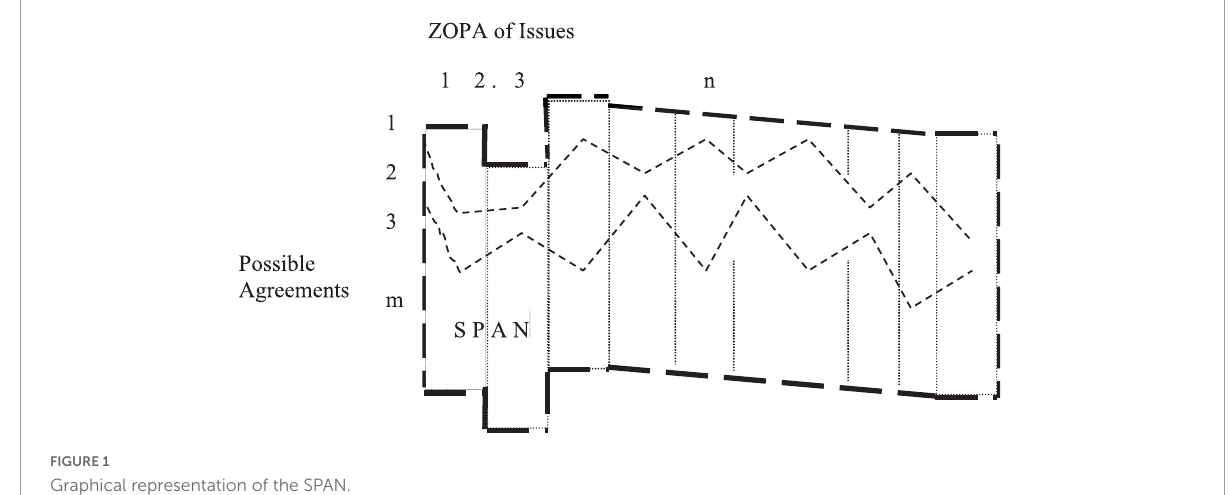
FIGURE1 Graphical representation of the